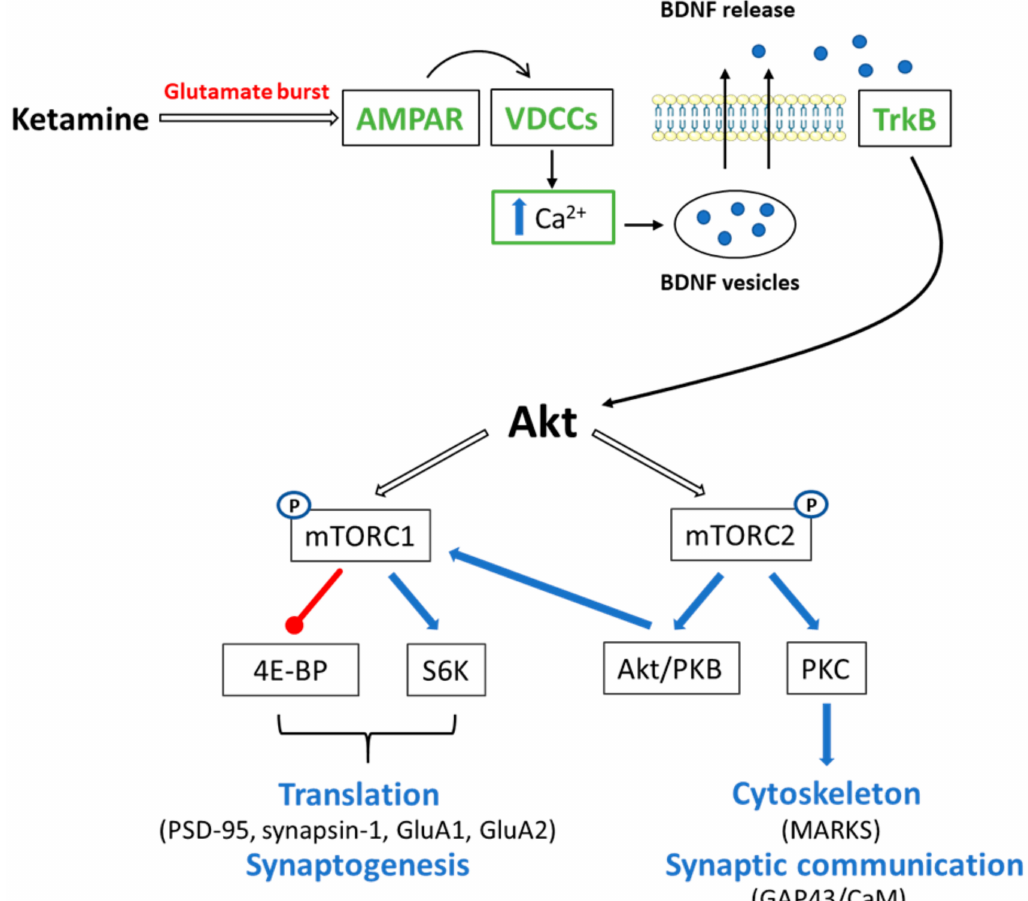
Figure 3. Schematic action of ketamine on mTOR pathway. Ketamine blockade of NMDARs on